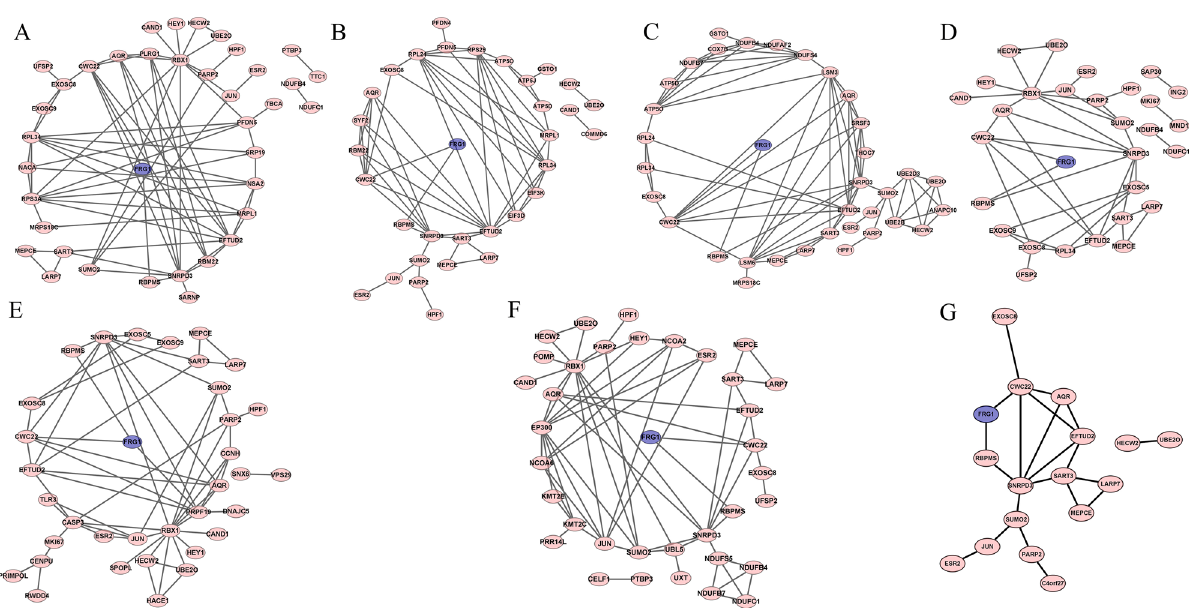
Figure 8. Co-expression and protein–protein interaction network analysis of FRG1 in different cancer types. Networks show FRG1 in blue at the center, and other genes with pink for ( A ) Breast Cancer (node = 38, edge = 72), ( B ) Prostate cancer (node = 33, edge = 62), ( C ) Lung Cancer (node = 35, edge = 78, ( D ) Cervix-Uteri cancer (node = 30, edge = 42), ( E ) Stomach cancer (node = 35, edge = 61), and ( F ) Liver Cancer (node = 36, edge = 64). ( G ) Common network across cancer types (node = 17, edge = 21). Nodes represent the number of genes and edges define interaction between